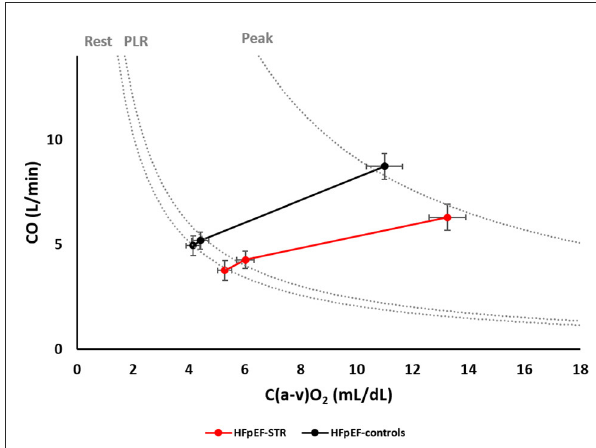
FIGURE3 Relative weight of cardiac output and arteriovenous oxygen difference in determining oxygen consumption at rest, during passive leg raising and at peak exercise. Dotted lines represent oxygen consumption isophlets, i.e., cardiac output and arteriovenous oxygen difference coordinates whose product is a given oxygen consumption, at rest, during passive leg raising, and at peak exercise. C(a-v)O 2 , arteriovenous oxygen difference; CO, cardiac output; HFpEF, heart failure with preserved ejection fraction; PLR, passive leg raising; STR, secondary tricuspid